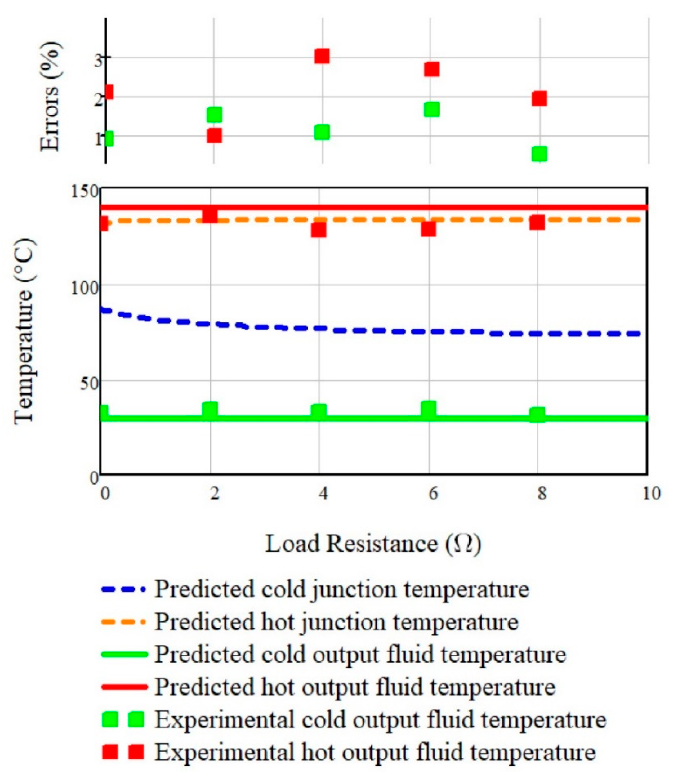
Figure 11. The relation between temperatures and the error associated with outlet temperatures and load resistance.